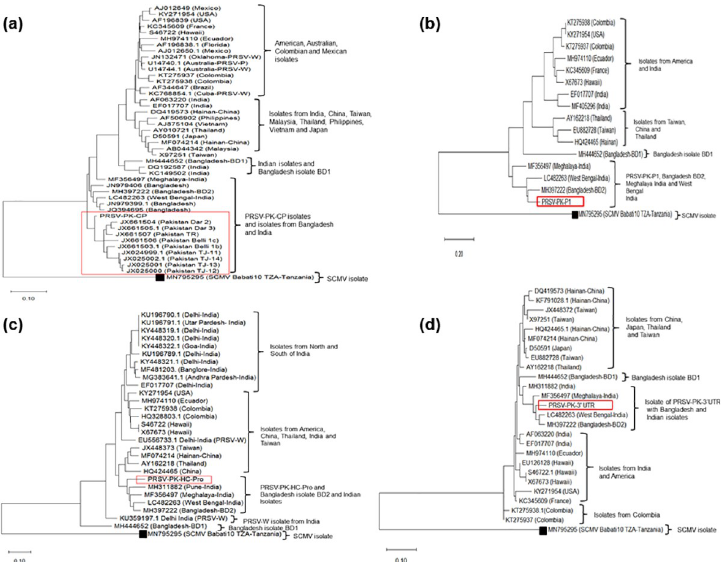
Fig 2. Maximum likelihood tree representing phylogenetic relationships of Papaya ringspot virus -P strain PK (PRSV–PK). (a) Coat Protein (CP) sequence (b) Protease P1 sequence (c) Helper component HC-Pro Sequence (d) 3’UTR sequence from other related sequences selected via BLAST search. Corresponding CP, P1, HC-Pro and 3’UTR sequences of Sugarcane mosaic virus (SCMV) (accession no. MN795295) used as outgroup. Upper and lower branch points show bootstrap values (1,000 replicates) supporting a particular phylogenetic group. The scale bar represents nucleotide substitutions per site. All nucleotide sequences are retrieved according to the isolate name and the GenBank accession